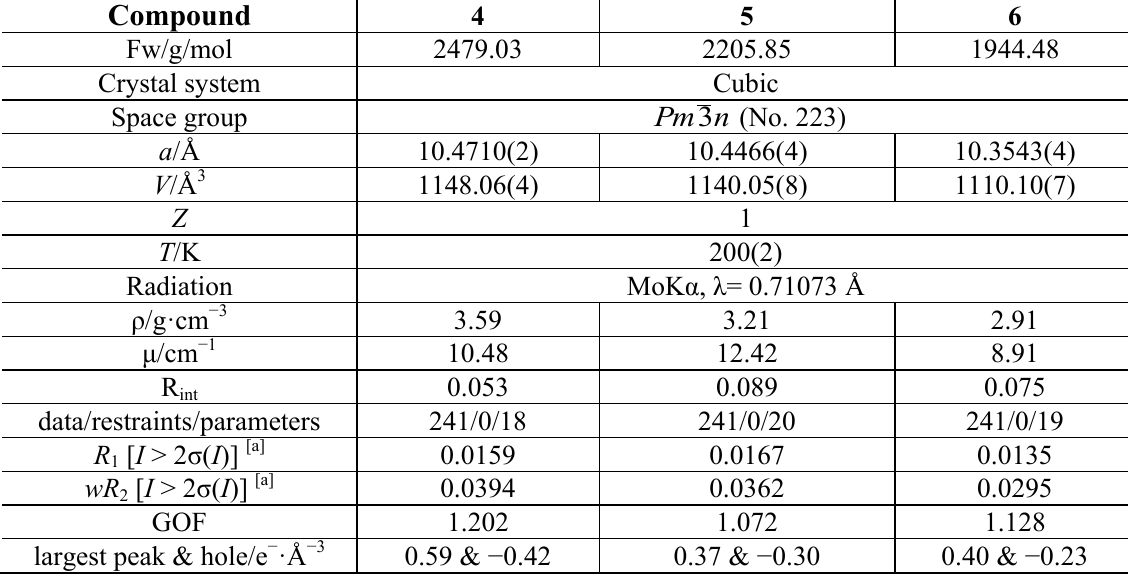
Na Ga Si 6 2 8.25